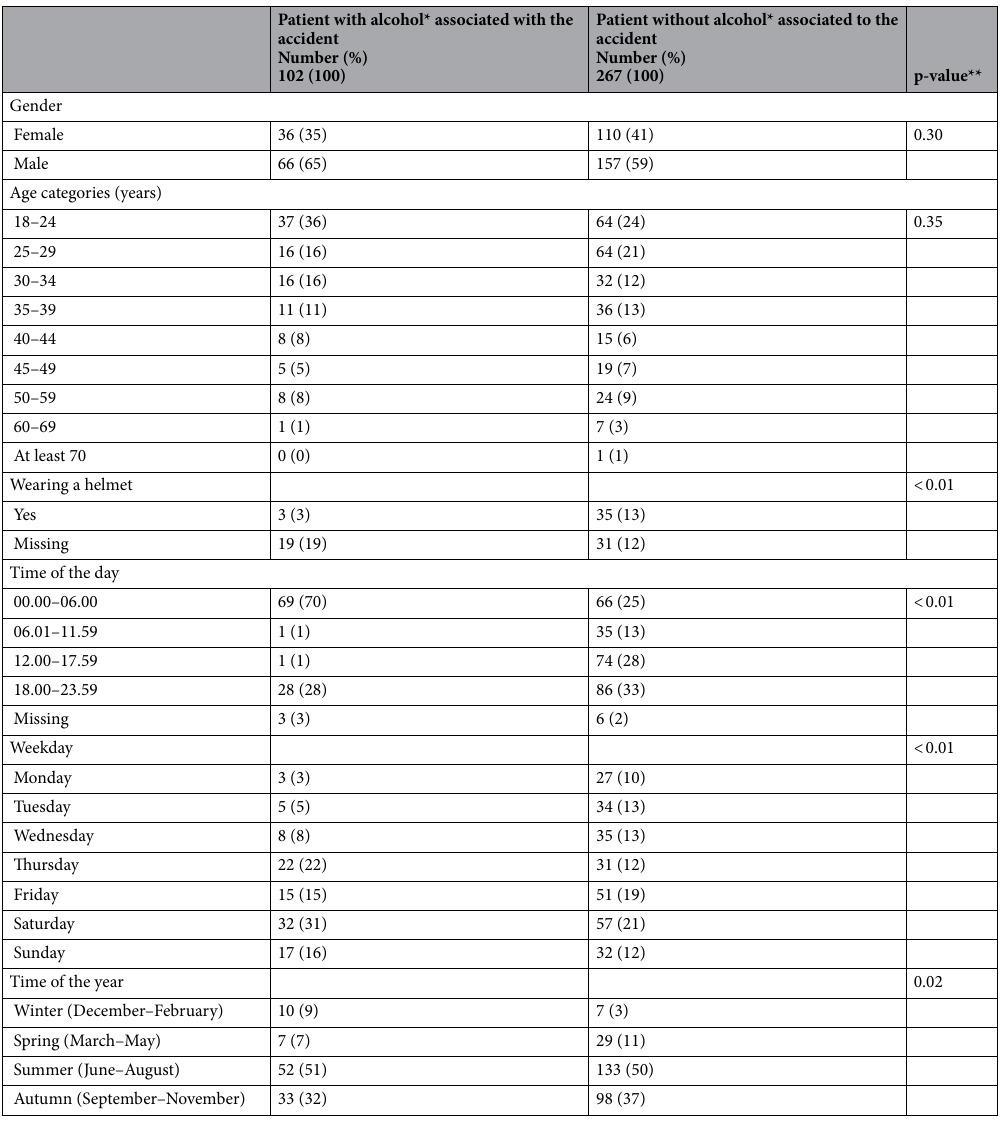
Table 1. Characteristics of all patients visiting an emergency department due to an accident with an electric scooter in Stockholm, Sweden 2019–2020. *Alcohol in blood was determined as either a note of self-reported intake of alcohol in the medical file written by the physician or a value over 0 on the laboratory test serum- ethanol taken at arrival to the emergency department. **Chi squared test between all patients with alcohol compared to those without